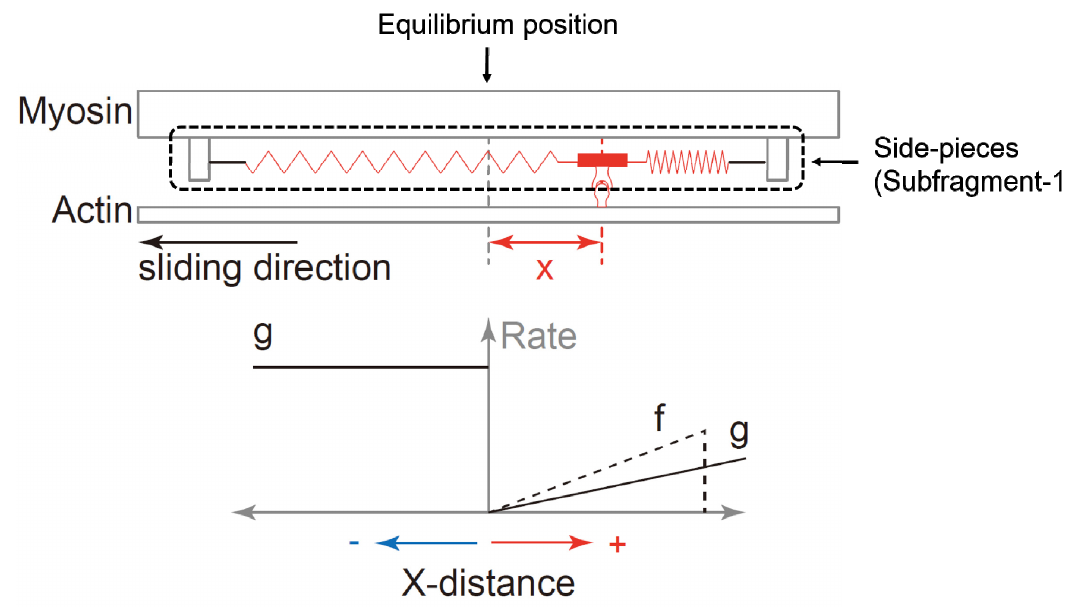
Figure 2. Schematic diagram of the cross-bridge theory proposed by A.F. Huxley [1]. The upper panel shows the structural model of the actin and myosin, and the lower panel shows the functional model of attachment and detachment rates suggested by A.F. Huxley [1]. When the myosin subfragment-1 (side-pieces) attaches to the actin filament, the actin filament is moved past myosin because of the elastic force produced by the springs that attach the cross-bridges to the backbone of the myosin filament. This elastic force (the force produced by the cross-bridge) depends on the distance of the nearest actin attachment site (indicated by the knob on the actin filament) to the equilibrium position (x-distance) of the cross-bridge. The rate constant of attachment and detachment is also dependent on the x-distance (the left lower panel). The vertical axis means the rate (probability) of attachment or detachment. Finally, the force of an entire muscle produced by the cross-bridges depends on the average force of the attached cross bridges and the number of attached cross-bridges.